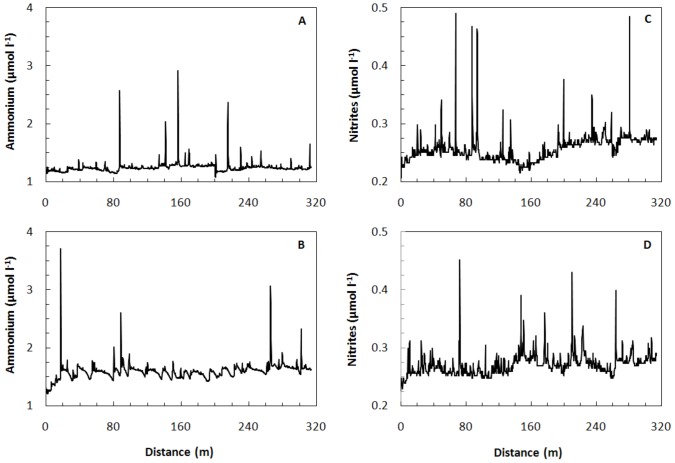
Ammonium and nitrite gradients in the Eastern English Channel at 3 s intervals.The steepest and largest gradients are at the shortest scales, those most relevant to individual phytoplankton cells.